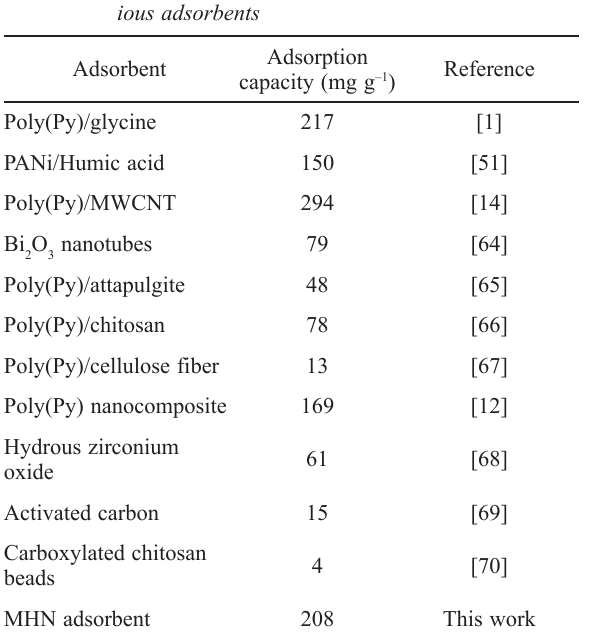
Table 3 – Comparison of sorption capacity of Cr(VI) on var- ious adsorbents